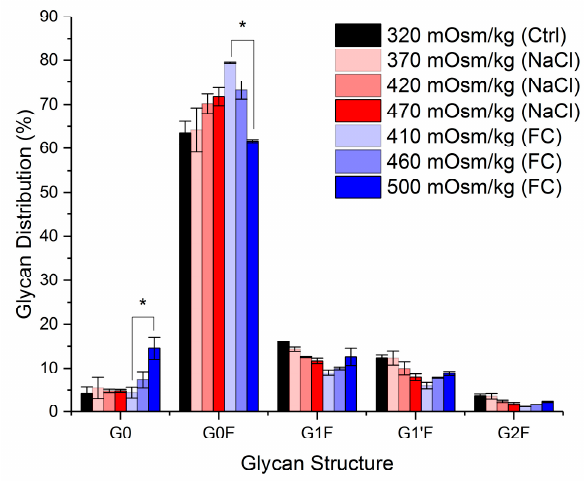
Figure 6. Glycosylation profile for control, NaCl and Feed C experiments at harvest. Error bars represent the standard deviation of two biological replicates. For the analysis of significance (* p < 0.05), equal variance of each variable between different experiments was assumed.